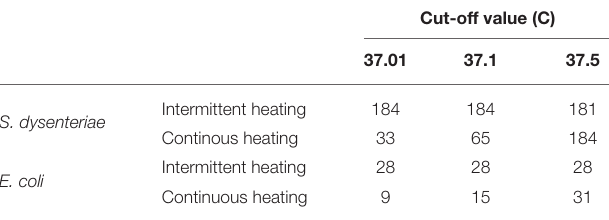
TABLE 2 | Intermittent vs. continuous heating impact on pathogen growth reduction (in arbitrary units) with different temperature cut off values for the